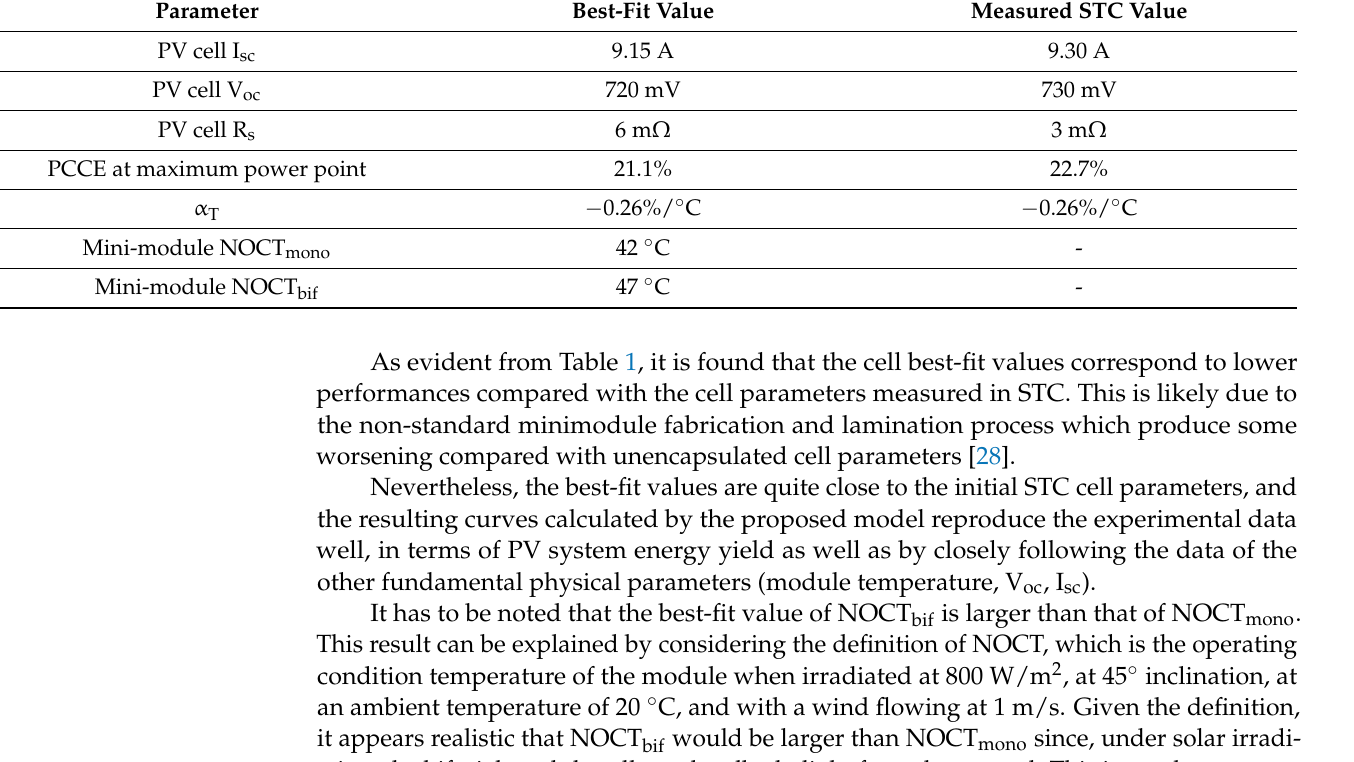
Table 1. Best-fit values of the proposed model compared with the STC cell values. Parameter Best-Fit